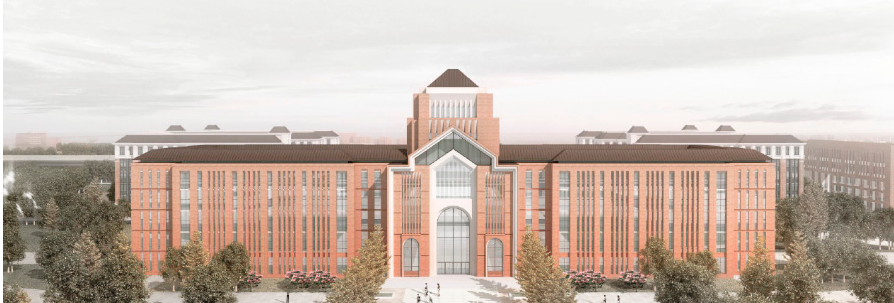
Figure 3. The initial form of the reference building.